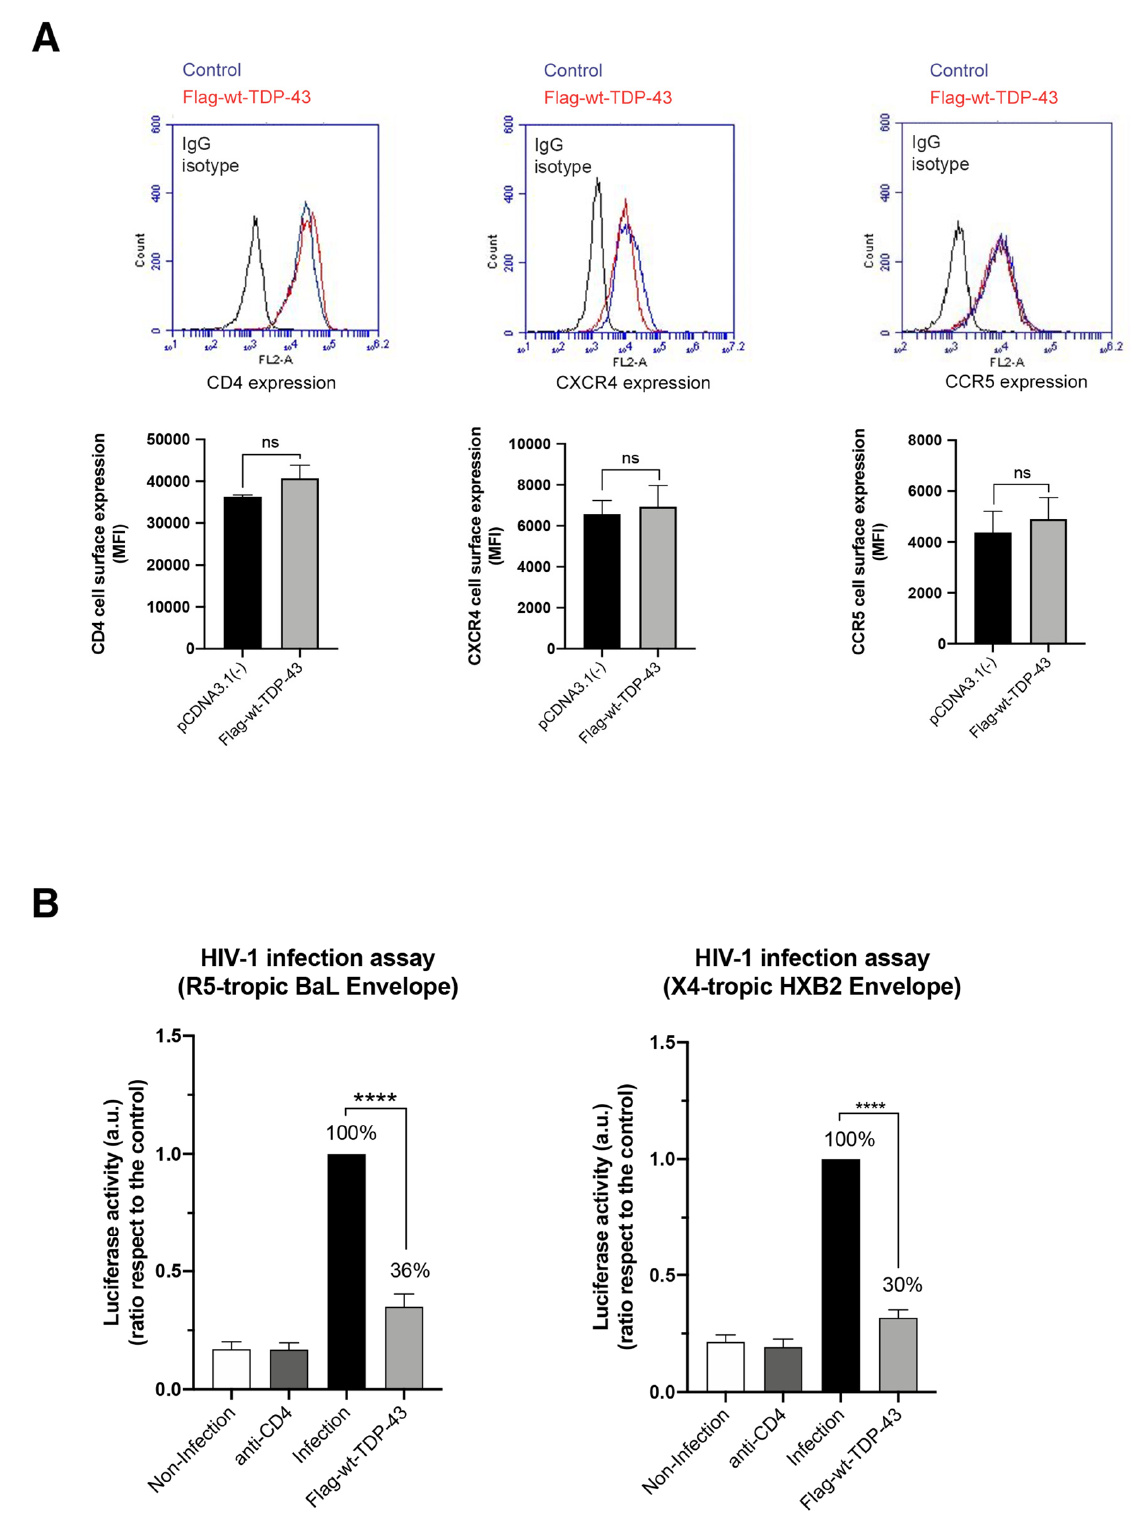
Figure 2. Effect of TDP-43 overexpression on cell-surface expression of HIV-1 main receptor and co-receptors and on viral infection. ( A ) Flow cytometry analysis of CD4, CXCR4 and CCR5 cell- surface expression in CEM.NKR-CCR5+/CD4+ T cells overexpressing the Flag-wt-TDP-43 construct. pcDNA3.1( − ) represents control cells nucleofected with the pcDNA3.1 plasmid (1 µ g cDNA of